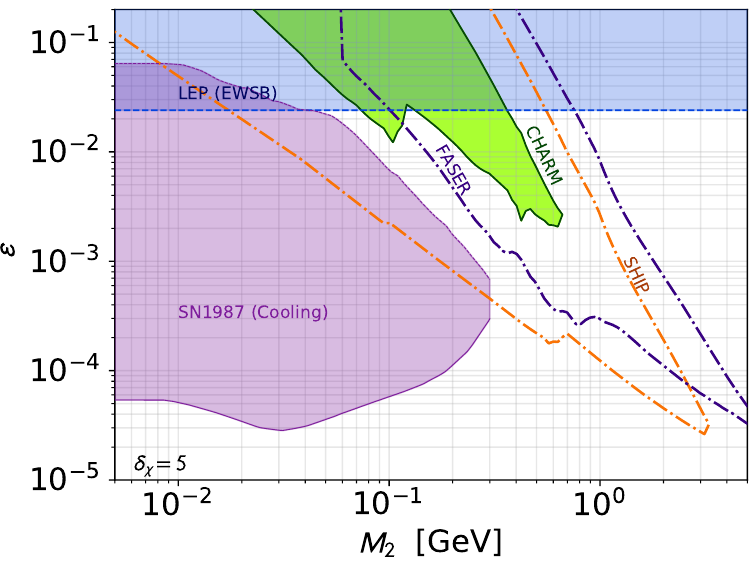
Figure 15 . Limits and projected sensitivity to a heavy dark photon mediator coupled to dark sector fermions, with M V = 20 GeV. LEP mono- (cid:13) bounds are shown in shaded blue. For limits from (cid:31) 2 ! (cid:31) 1 e + e (cid:0) , the dark green region is the exclusion from CHARM [46] and the 10 events reach by SHiP is shown in dashed orange. We also show a projection for FASER from [66]. The normalised splitting (cid:14) (cid:31) is de(cid:12)ned in eq.